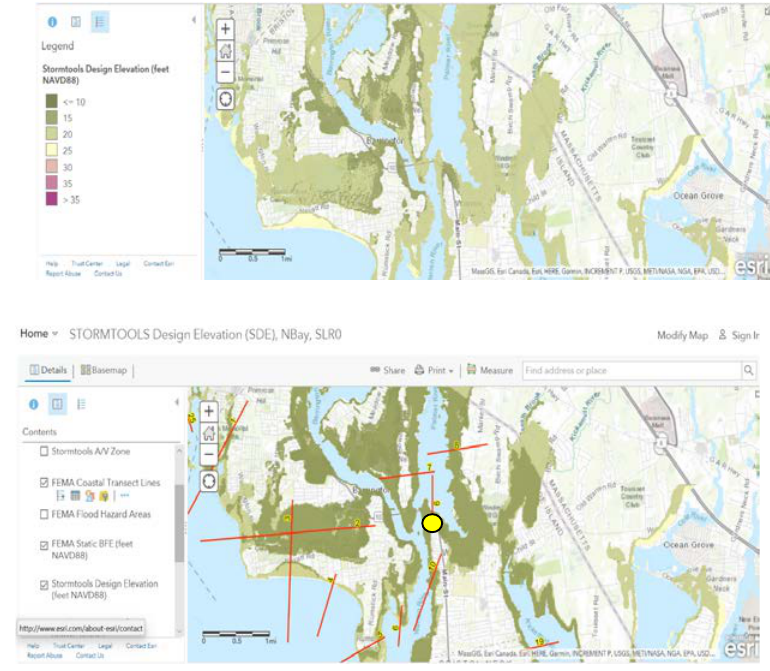
Figure 13. Flooding in the vicinity of Barrington, Warren, and Bristol, RI, for 100-yr, no-SLR case. The point interrogation tool was used to determine the BFE at the location selected. The interface also allowed the user to compare and contrast the FEMA FIRMs and SDE maps.